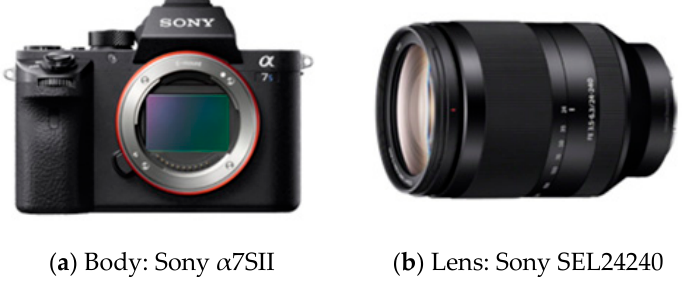
Figure 9. Single-lens reflex camera.